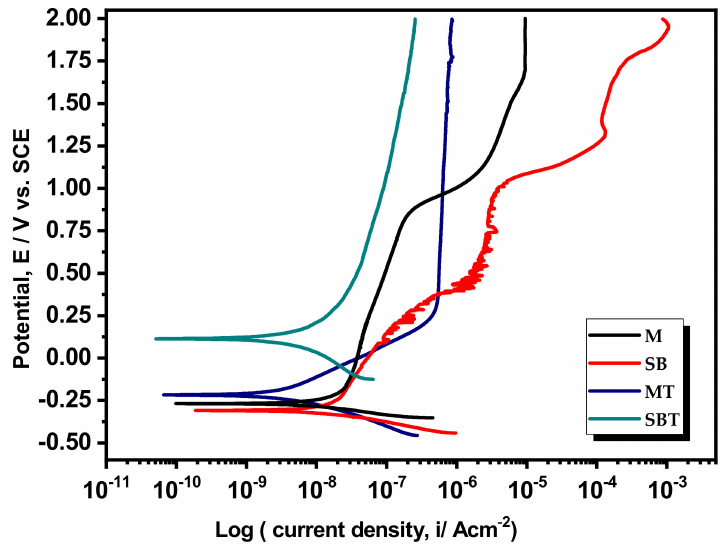
Figure 8. PDP plots of the pretreated and treated Ti64 specimens in Hank’s